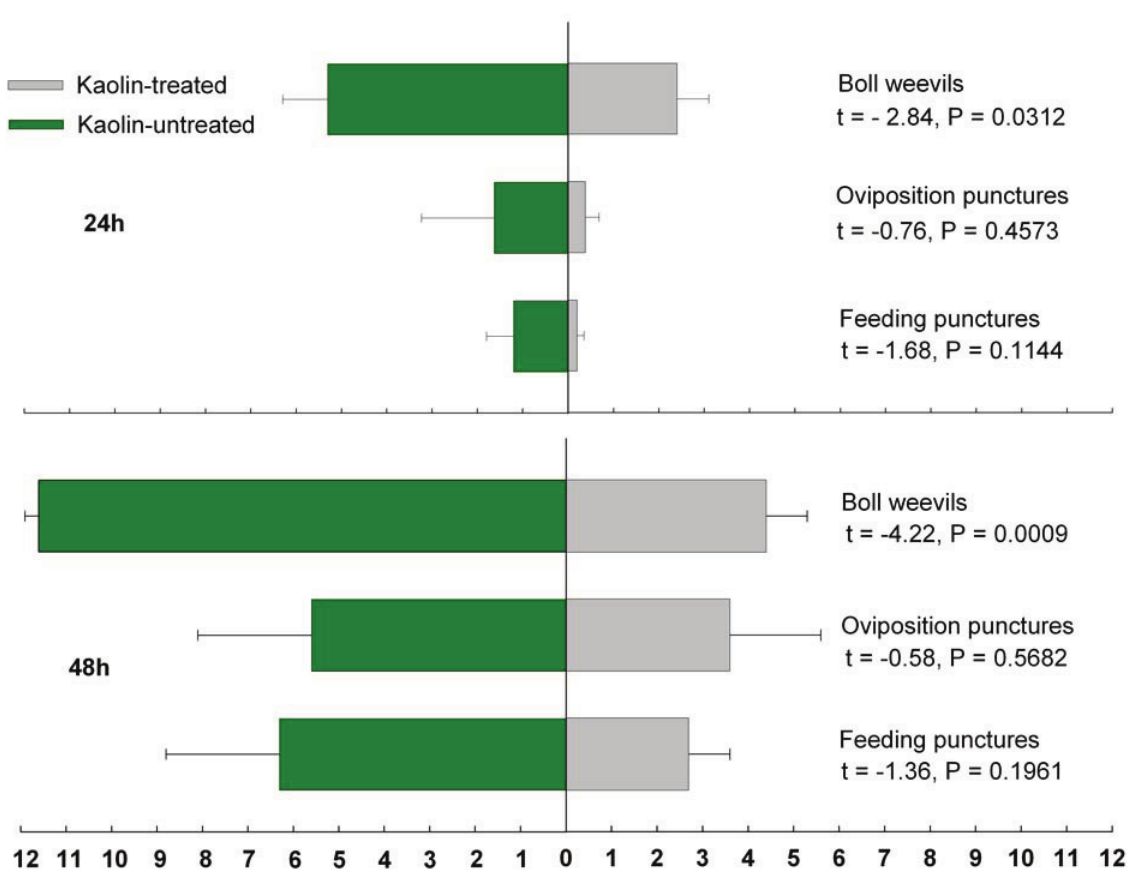
Figure 1. Mean number of boll weevils ( Anthonomus grandis ) recovered, and structures with damage (oviposition and feeding